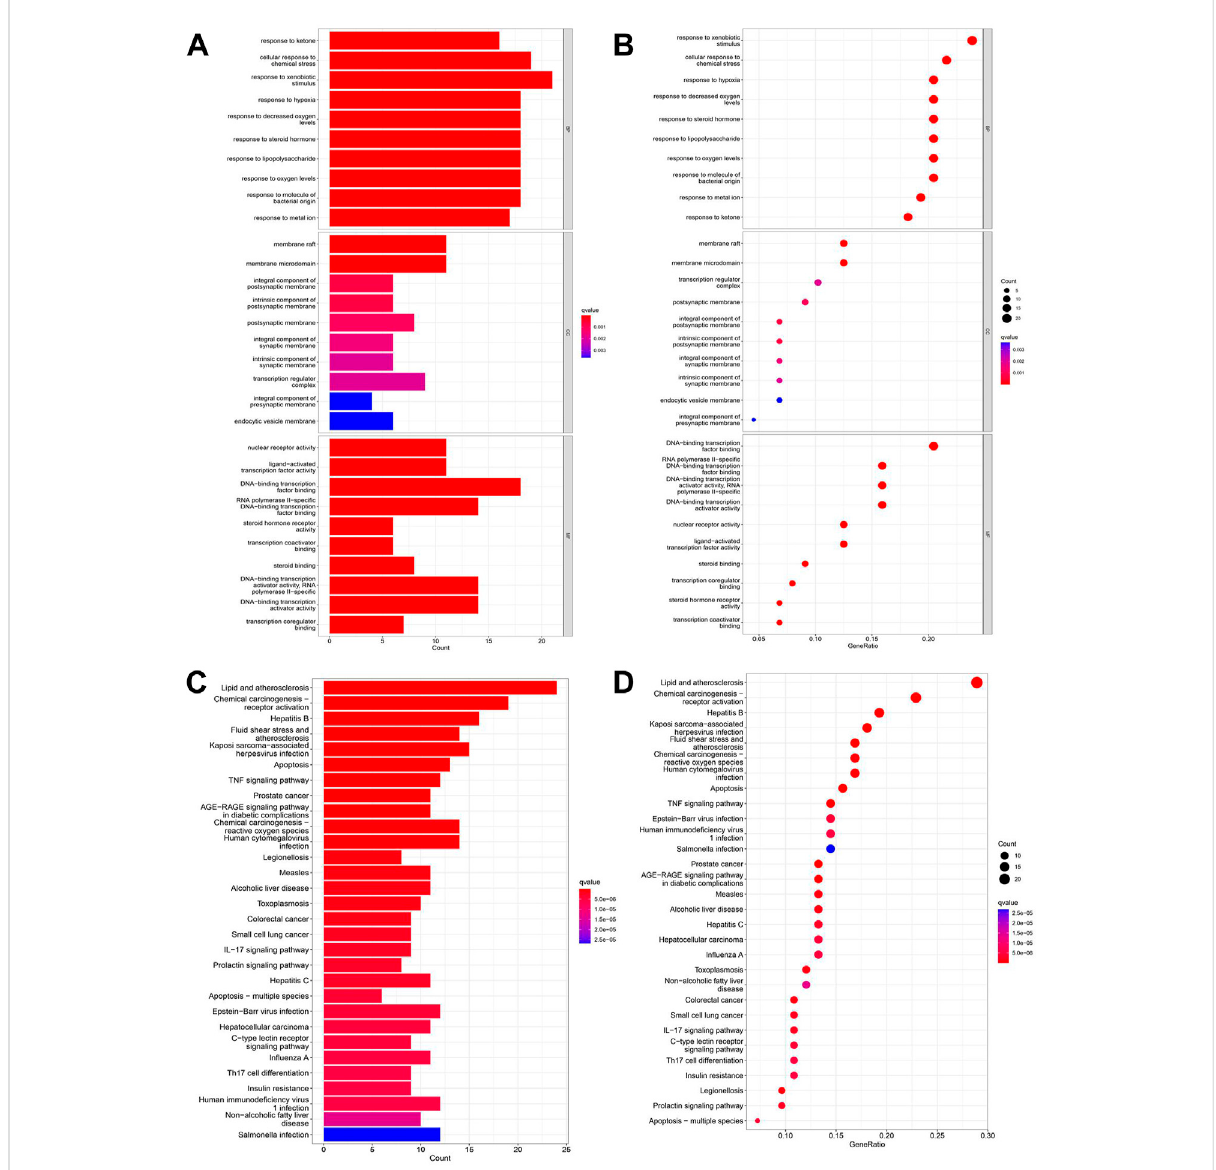
FIGURE 2 GO and KEGG enrichment analyses of intersections. (A) Barplot of GO annotation which shows the top 10 signi fi cantly enriched terms in molecular function (MF), biological process (BP), and cellular component (CC) respectively. (B) Bubble diagram of GO annotation which shows the top 10 signi fi cantly enriched terms in MF, BP, and CC respectively. (C) Barplot of KEGG enrichment analysis which shows the top 30 signi fi cantly enriched terms in the KEGG pathway. (D) Bubble diagram of KEGG enrichment analysis which shows the top 30 signi fi cantly enriched terms in the KEGG pathway. Gene ratio = count/set